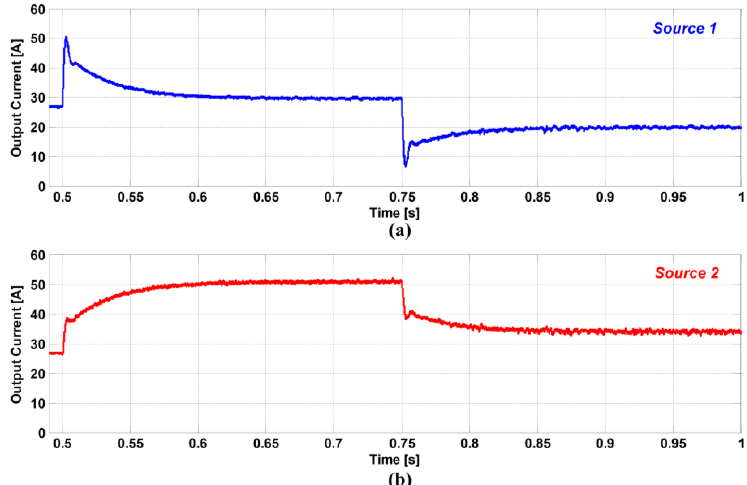
Figure 15. Simulation results of the proposed approach with step-up/step-down changes. ( a ): Source 1 Output Current, ( b ): Source 2 Output Current.